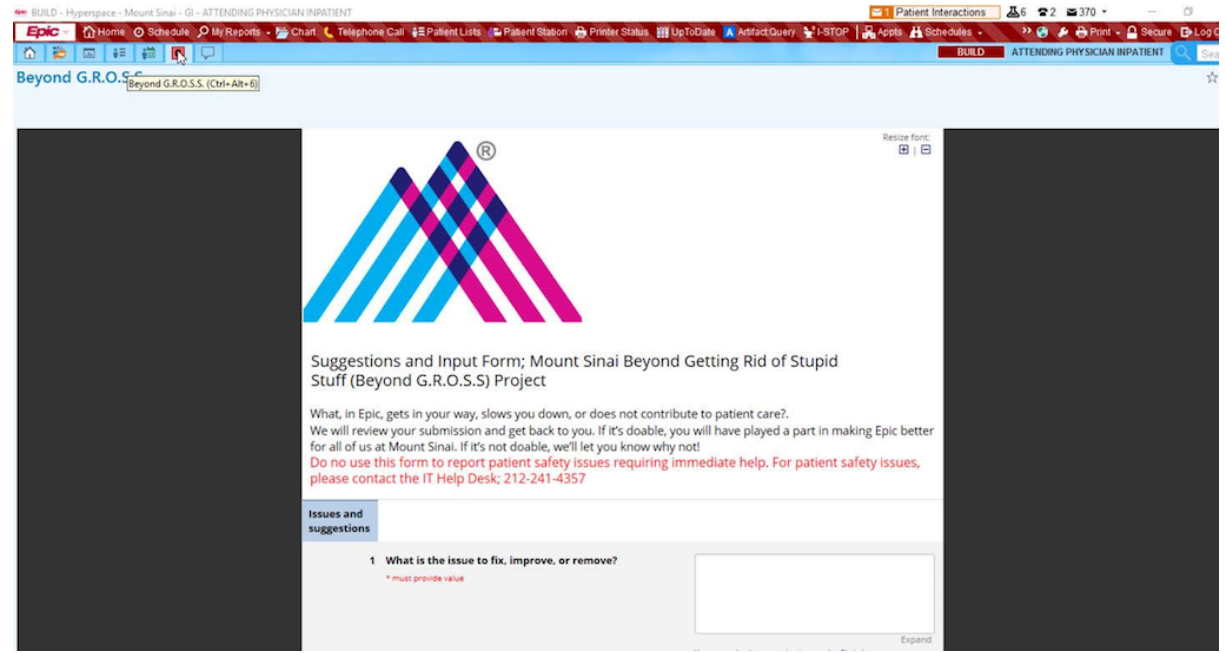
Figure 2. Beyond-Getting Rid of Study Stuff (GROSS) link embedded in the electronic health record (EHR).